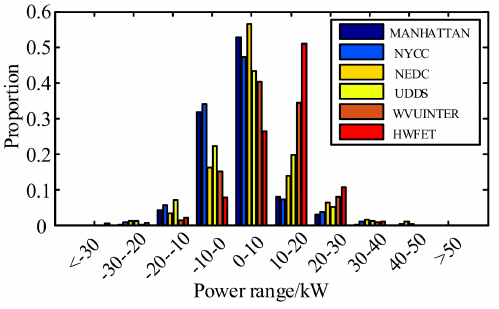
Figure 5. Power distributions under various driving